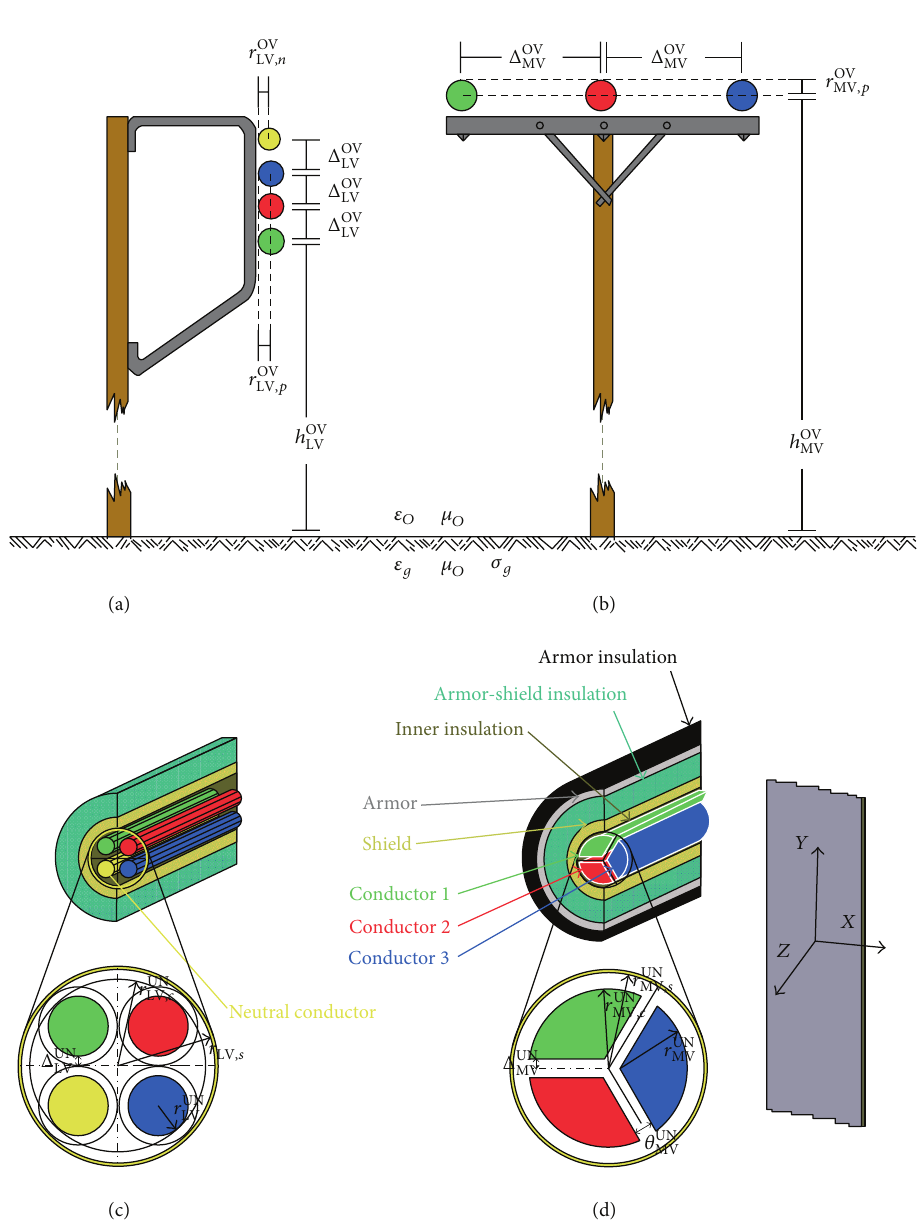
Figure 1: Typical multiconductor structures [38]. (a) Overhead LV. (b) Overhead MV. (c) Underground LV. (d) Underground MV.